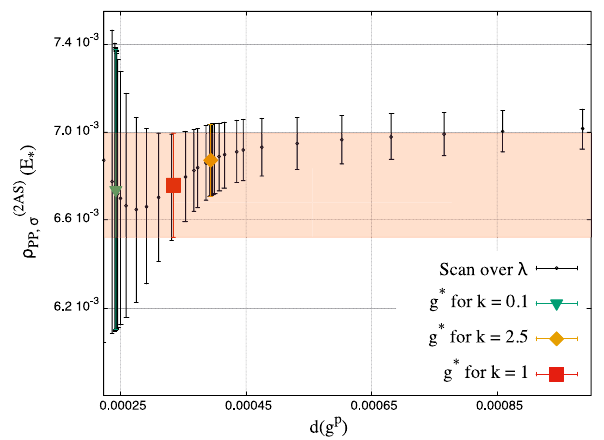
Fig. 7 Example of region of algorithmical stability at a given energy E (cid:24) . Different values of λ, which translate into different values of d ( g p ) on the x-axis, produce predictions for the smeared spectral density ρ R ( E (cid:24) ) that are compatible within statistical error (black bars). In PP ,σ ( 2AS ) . The green and this case, R = 2AS , σ = 0 . 21 / a and E (cid:24) (cid:4) M PP orange points correspond, according to Eq. (64), to values of k = 0 . 1 and k = 2 . 5 respectively. The red point, extended in the horizontal band, is obtained at k = 1 and it corresponds to the value of λ at which one achieves the optimal balance A α [ g (cid:24) ] / A α [ 0 ] = B [ g (cid:24)